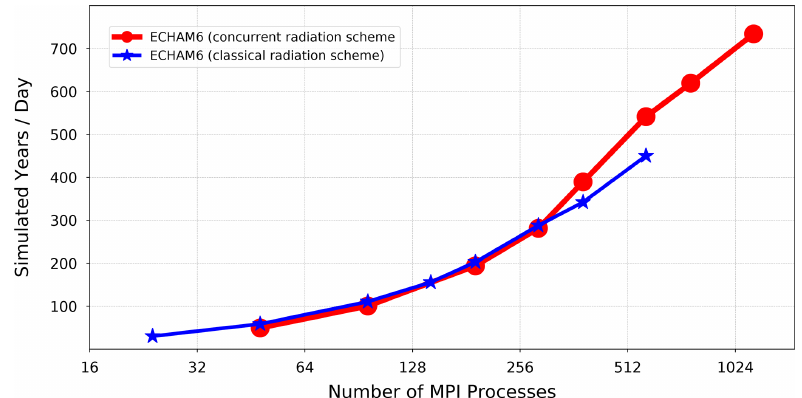
Figure 6. The scaling curves of ECHAM6 using the classical and concurrent radiation schemes.